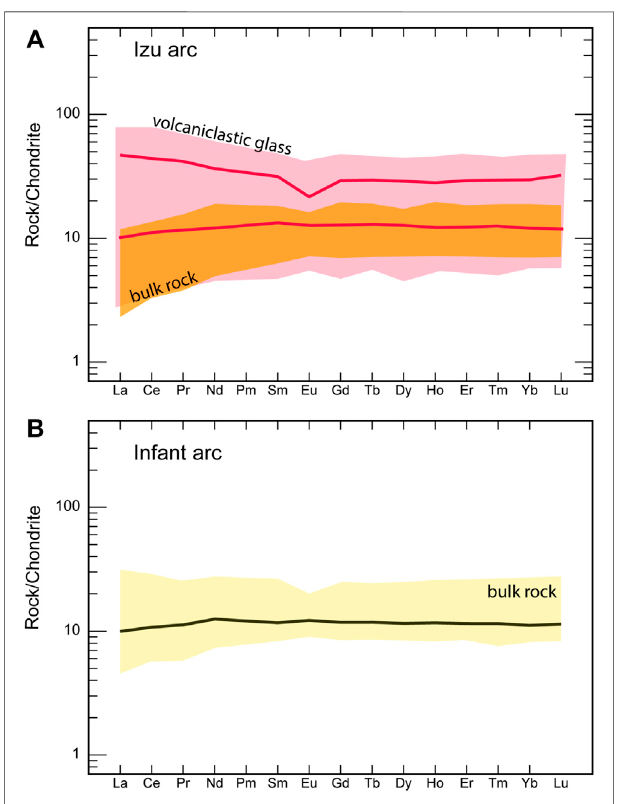
FIGURE 5 | Chondrite-normalized rare Earth element patterns. (A) Izu basaltic glass shards (red compositional fi eld); and (B) infant arc basalts (whole rock in yellow compositional fi eld). Representative REE patterns for the Izu mature arc and for the Izu infant arc are also depicted as thick red lines (A) andathickblackline (B) ,respectively.Diagramsarenormalizedusing the chondrite contents of Sun and McDonough (1989). The orange compositional fi eld in panel A represents the mature arc magmas (bulk analyses) from the compiled dataset of DeBari et al. (2020). Detailed REE patterns can be found in the Supplementary Material